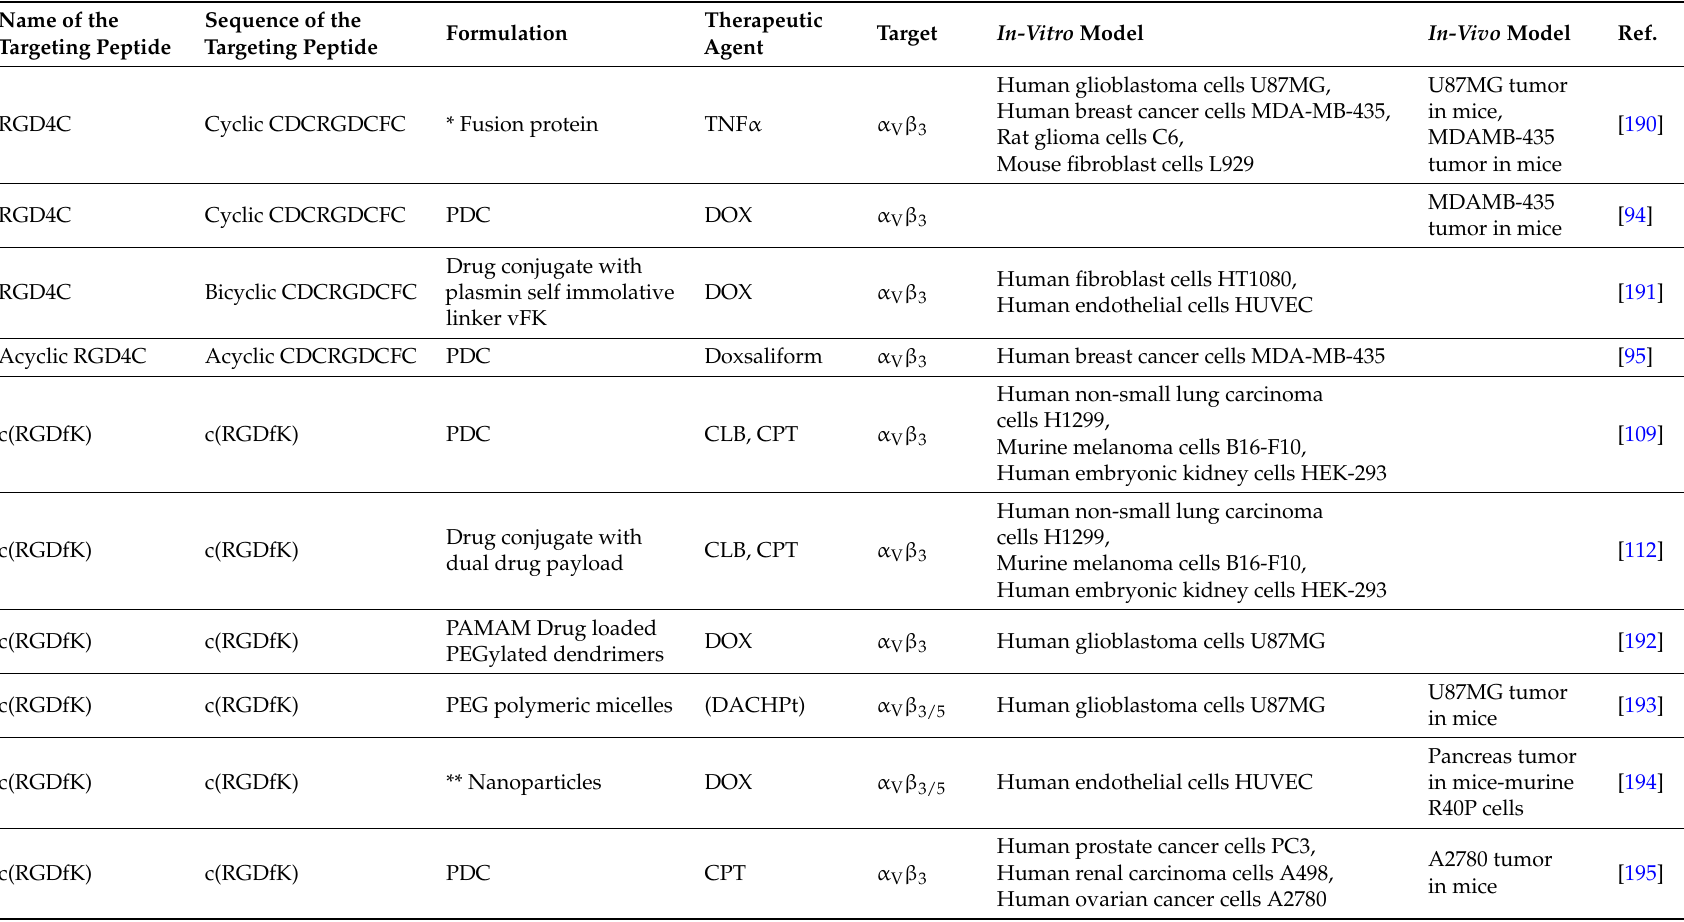
Table 2. Targeted drug delivery (TDD) systems based on Arginine-Glycine-Aspartic acid (RGD) sequence as targeting agent. * For additional examples